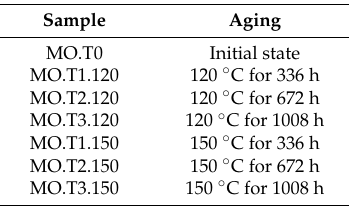
Table 1. Sample and treatment.